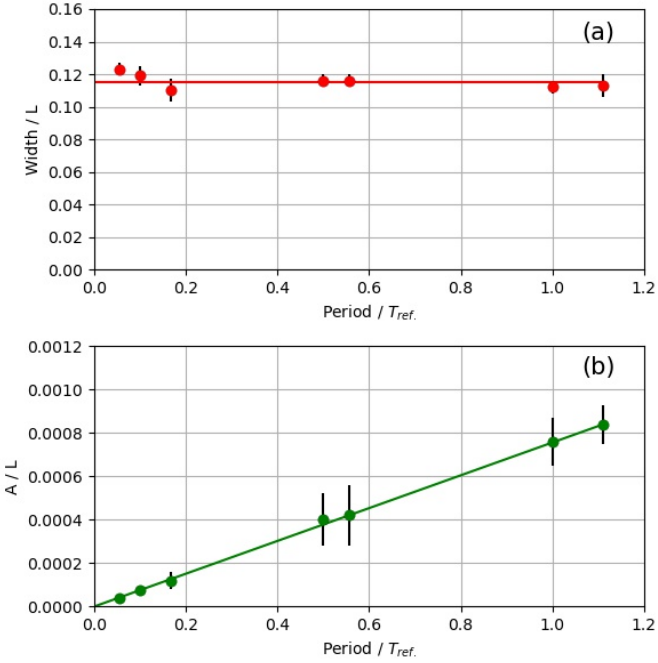
Figure 12. Morphological signature of slip rate along the fault scarp outside the area affected by the alluvial fan ( | X / L | > 0.2 ) . ( a ) Mean elevation profiles associated with stick-slip (blue line) and stable sliding (orange line). The green line shows the deviation between these two fault slip behaviors. Note the coefficient of ten used to highlight this deviation. W and A are the deviation width and amplitude, respectively. ( b ) Red circles show the variation of W obtained from numerical modeling with respect to fault slip rate. The obtained linear trend is given by the red line. v ref is the fault slip rate used in the reference model (see Table 1). ( c ) Relationship between the deviation amplitude A and the fault slip rate obtained from numerical modeling (green circles). The green line shows the linear trend between these two parameters.